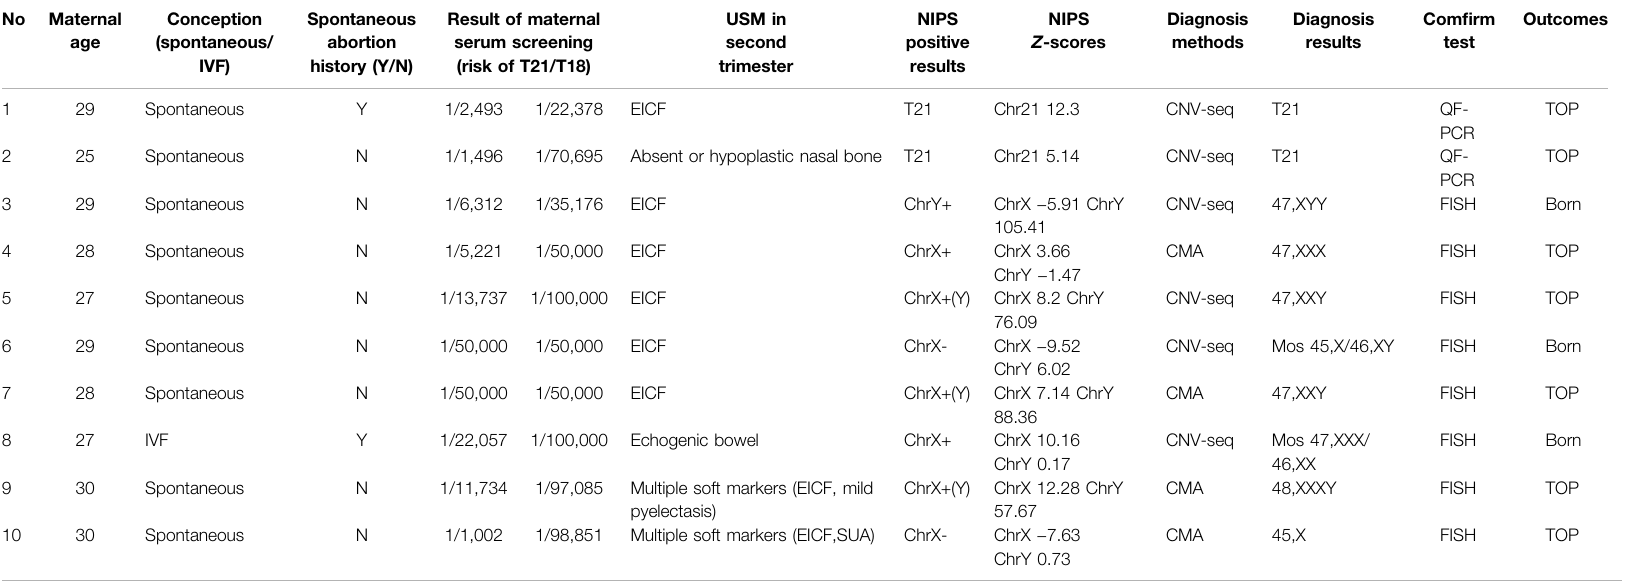
TABLE 5 | Clinical details of the 10 cases with fetal aneuploidy and positive